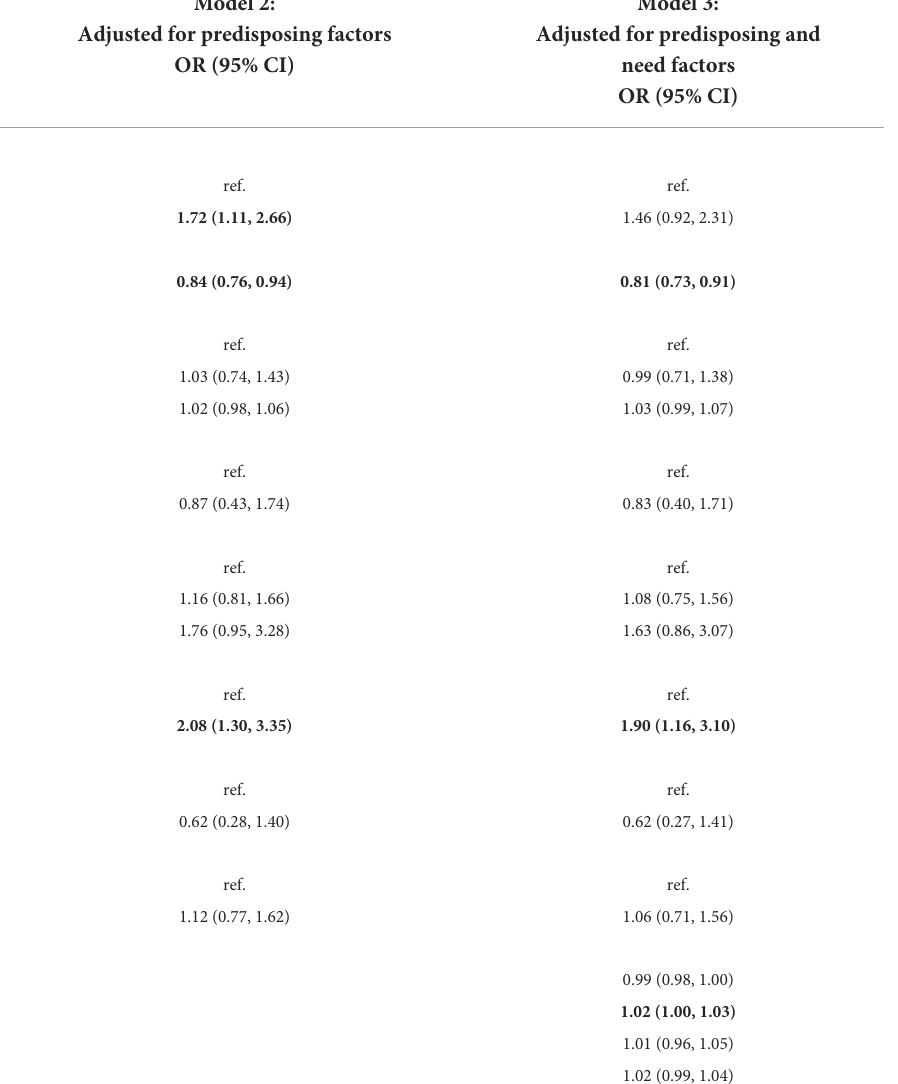
Tableisbasedontheimputeddataset.p-Values < 0.05inbold.ORsand95%confidenceintervalswerederivedfromthemultivariablelogisticregressionmodels. OR,oddsratio;CI,confidenceinterval;ref.,referencegroup.